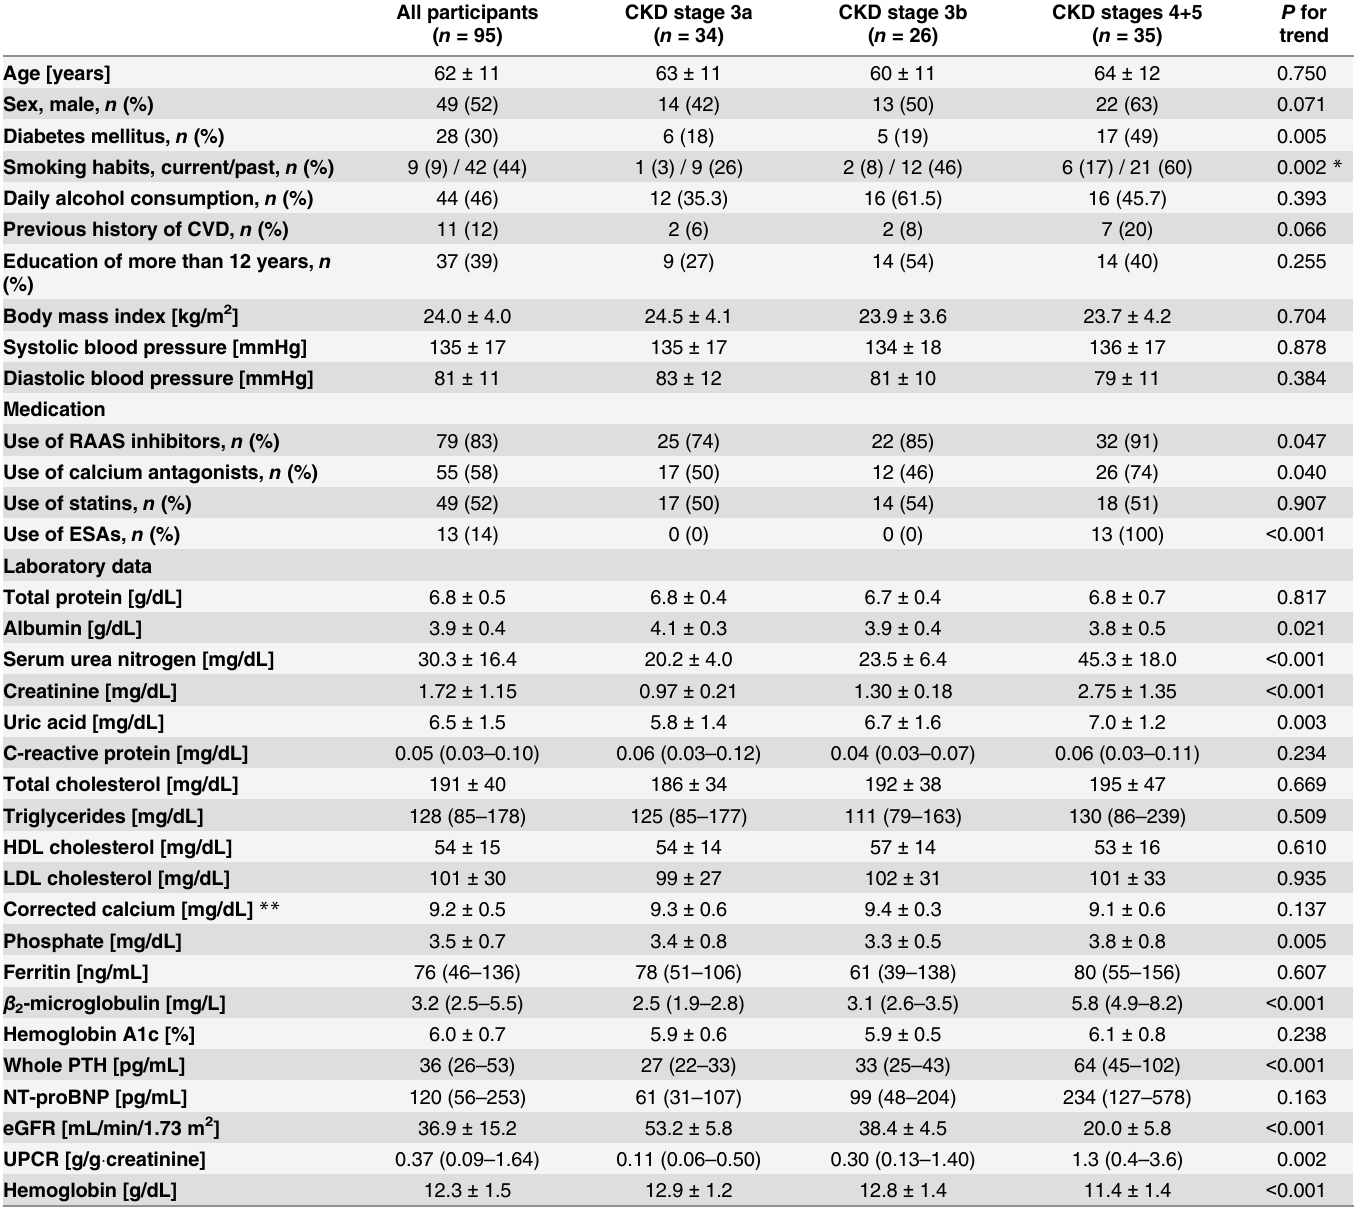
Table 1. Clinical Characteristics and Laboratory Data of All Participants According to CKD Stages. Values for categorical variables are given as num- ber (percentage); values for continuous variables are given as mean ± standard deviation or median (interquartile range). Abbreviations: eGFR,